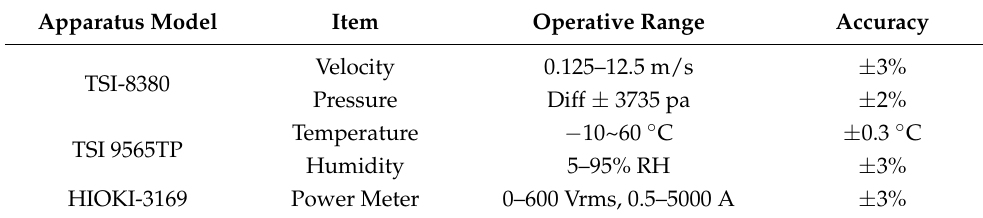
Table 1. Apparatus for the field